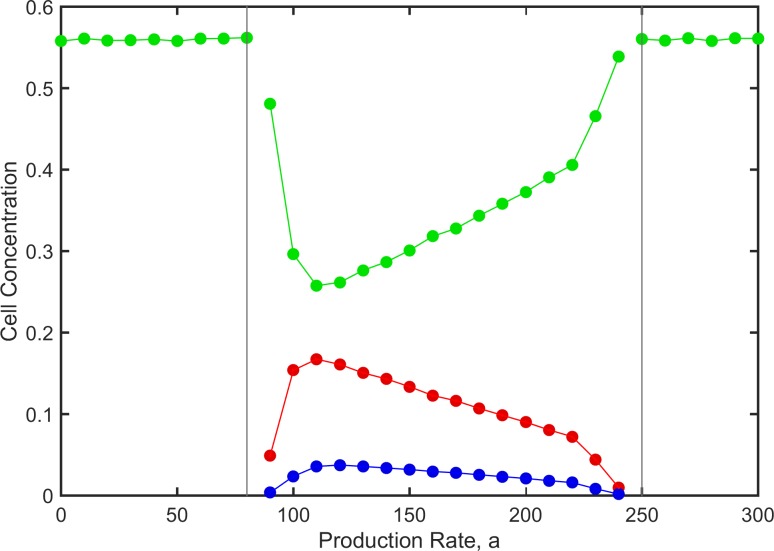
Time averaged cell concentrations for the surviving cell types as a function of a in the presence of mutation between P and N.Parameters as in Fig 6. P—red; N—blue; S—green.